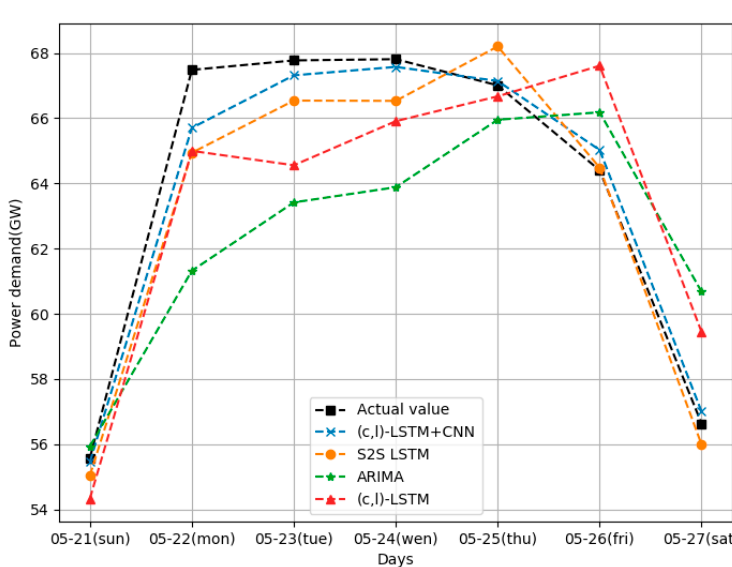
Figure 9. Forecasting performances on d 1 .